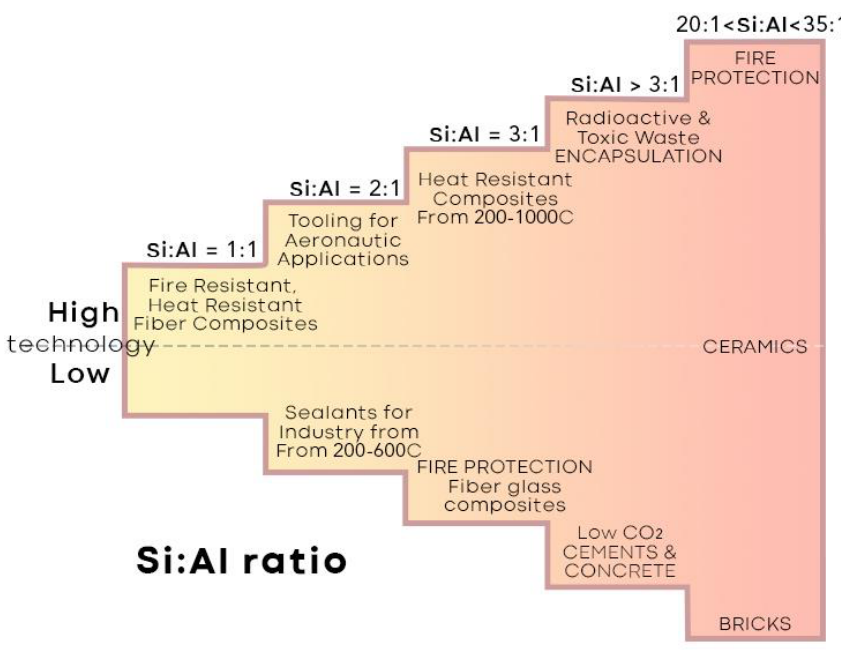
Figure 11. Geopolymer product dependence on the molar ratio of Si/Al.